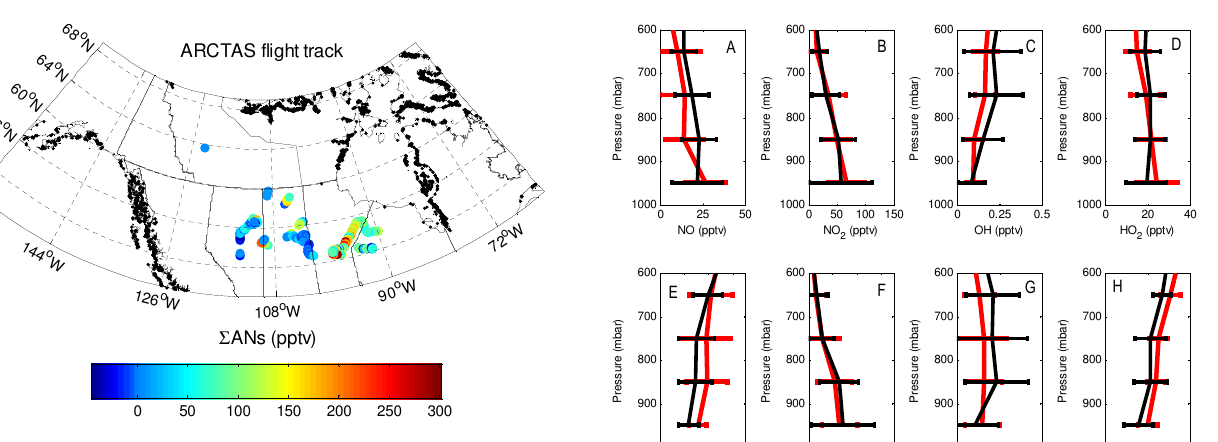
Figure 1 Map of ARCTAS measurements of Σ ANs used in this analysis. These locations are 2 Fig. 1. Map of ARCTAS measurements of 6 ANs used in this anal- removed from recent biomass burning influences and are at pressures greater than 600 mbar. 3 ysis. These locations are removed from recent biomass burning in- fluences and are at pressures greater than 600mbar.